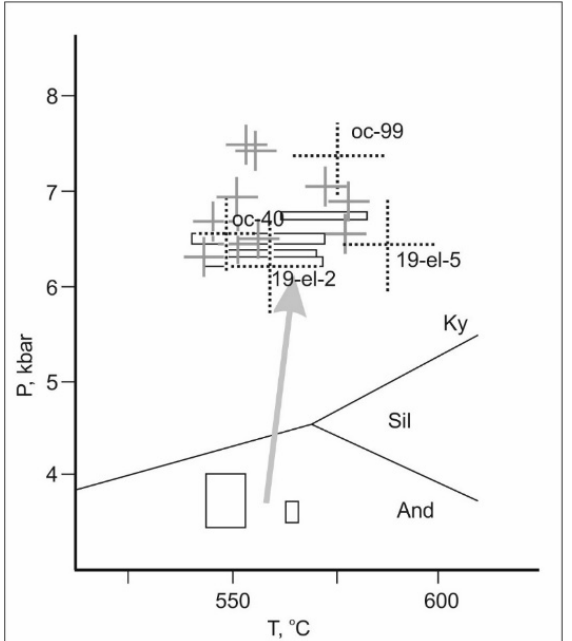
Figure 10. Pressure-Temperature diagram with parameters of metamorphism of the Mayakon area (rectangulars) [20] and Olympiada and Eldorado schists (crosses). Grey arrow shows the PT-path of schists of the Mayakon area from early HT/LP metamorphism to the late Barrovian-type metamorphism [20]. The early stage considered to be occurred as a result of the orogeny during late Meso- early Neoproterozoic. This is supported by earlier U–Th–Pb, Rb–Sr, and K–Ar data on granite-gneiss domes (1100–950 Ma) and the more recent single-zircon (U–Pb SHRIMP II) and 40/39Ar dating of metapelites, metabasites, and rapakivi granites (1140–870 Ma) [13, 22,45]. The age estimates around c. 1050 Ma, were obtained by U-Th-Pb dating of xenotime inclusions in the core of zoned garnet grains [21]. The age of the second (Barrovian-type) metamorphic episode is estimated in the range from 850 to 800 Ma. Age estimates are based on CHIME monazite dating [21] and much Ar-Ar data on biotite from metamorphic schists around the whole YK [13,20–22,30]. the time interval 800–850 Ma in the YK collisional orogen. Mineral assemblages and